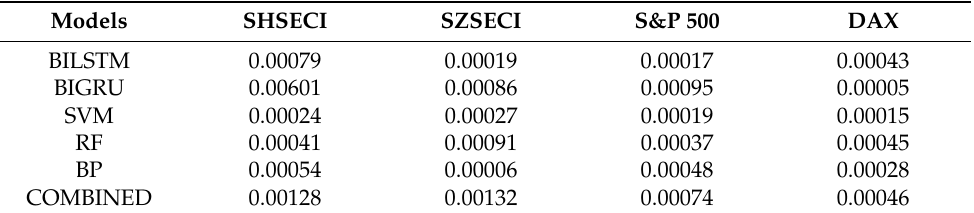
Figure 6 . Prediction performance of 7-day lag experiments.